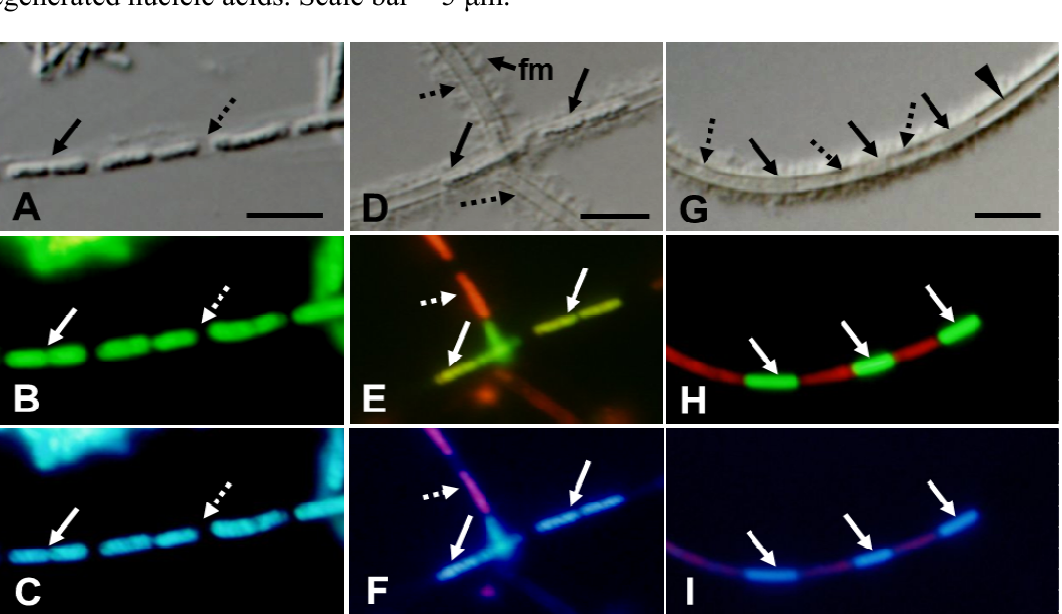
Figure 2. Strain OUMS1 and associated structures cultured in SGPI broth for 3 ( A – F ) and 7 days ( G – I ); DIC images ( A , D , G ) and fluorescent images from L/D stain ( B , E , H ) and from DAPI stain ( C , F , I ); images within a column are of the same cells. ( A – C ) Line of bacterial cells (solid arrow) and lengthwise intercellular spaces (dotted arrow) are encompassed by a faint, thin sheath. The cells (solid arrow) fluoresced a typical green from the L/D stain (vital sign), their nucleic acids fluoresced blue from DAPI, but the intercellular spaces (dotted arrow) did not fluoresce. Note the constriction at the center of the bacterial body [solid arrow in ( B ) and ( C )], signifying active cell division. ( D – F ) DIC-fluorescing cells (solid arrows) and barely fluorescing cells (dotted arrows) are enclosed with clearly defined walls covered with fibrous materials (fm). L/D and DAPI detected live cells (solid arrows) with intact nucleic acids and dead cells (dotted arrow) with atypical nucleic acids fluorescing pinkish. And ( G – I ) Barely distinguishable cells (solid arrows) enclosed with a thick-walled sheath, empty-looking (dotted arrows) and transparent zones with no detectable cells or cell remnants (arrowhead) in ( G ). Solid arrows: live cells with intact nucleic acid response; dotted arrows: dead cells with degenerated nucleic acids. Scale bar = 5 μ